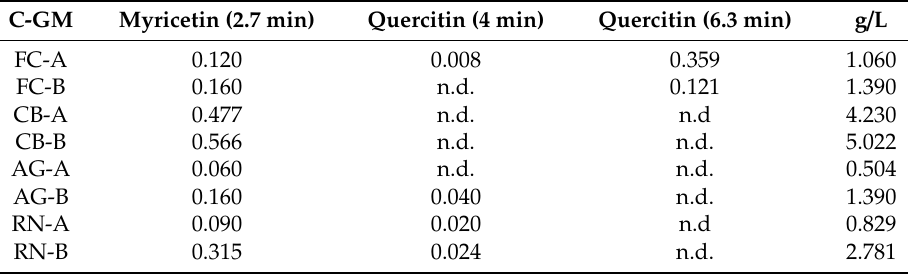
Table 1. HPLC analysis of myricetin and quercetin contents in